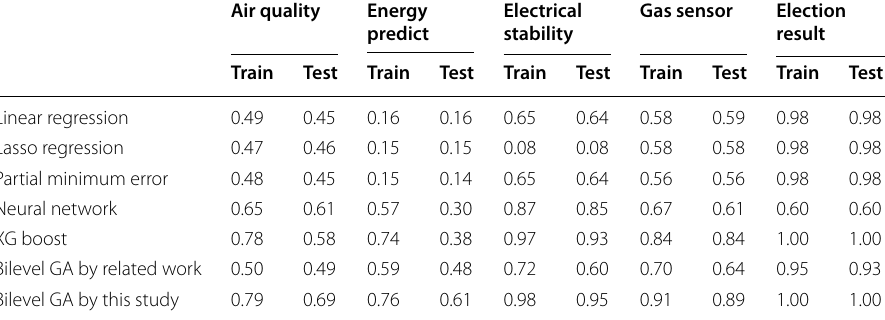
Table 4 Accuracy comparison of regression problems Air quality Energy